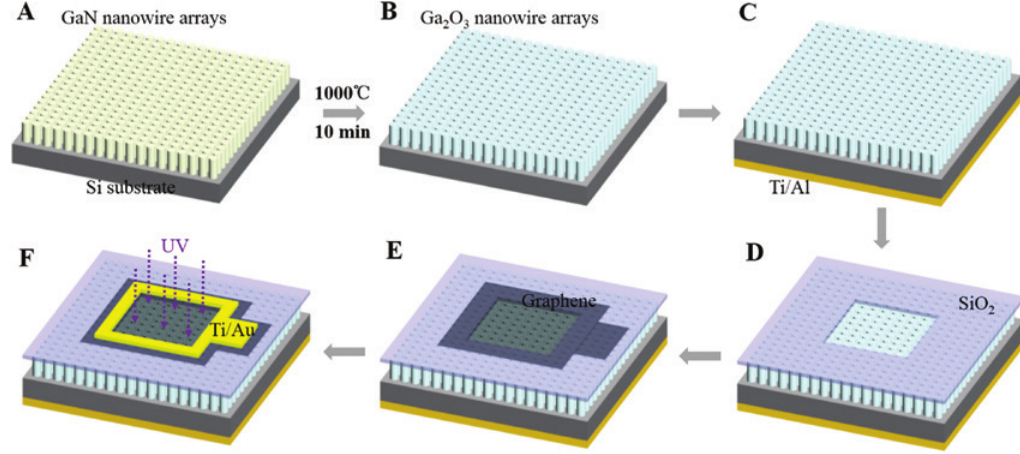
Figure 1: Schematic diagram of device fabrication. (A) Growing GaN nanowire arrays on Si substrate, (B) preparing Ga electrodes (Ti/Al), (D) depositing and selectively etching the SiO nanowires, and (F) depositing the front electrodes